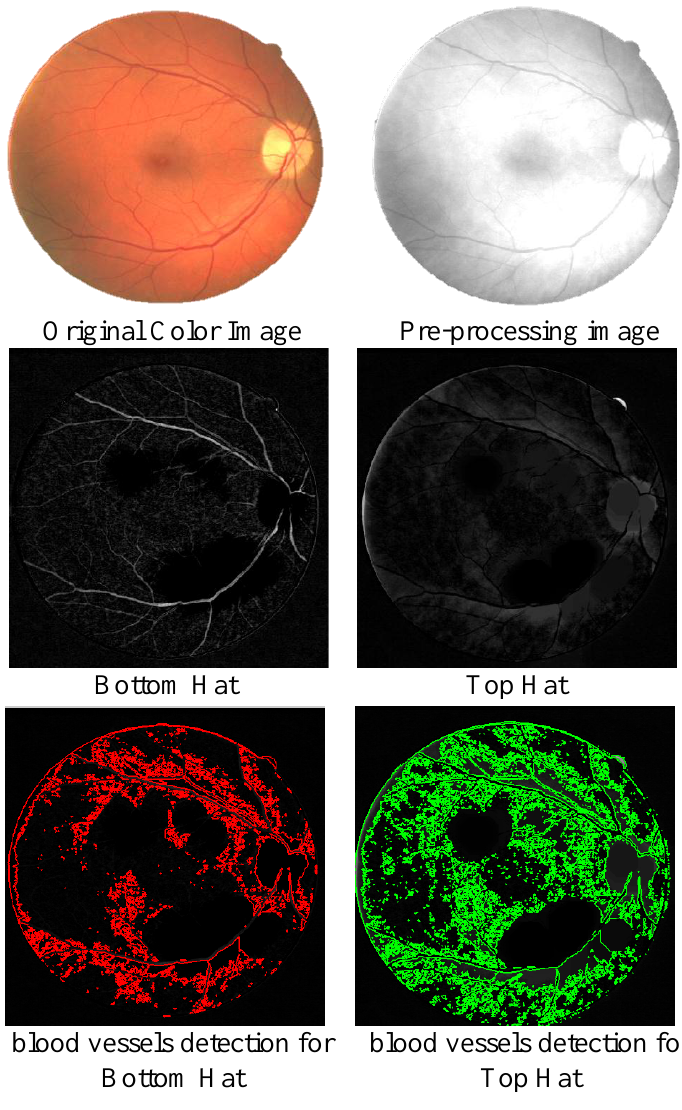
Fig. 11: Retinal fundus images which contain blood vessels (abnormalities) that can be detected using simple morphological operations using top, bottom hat method (from